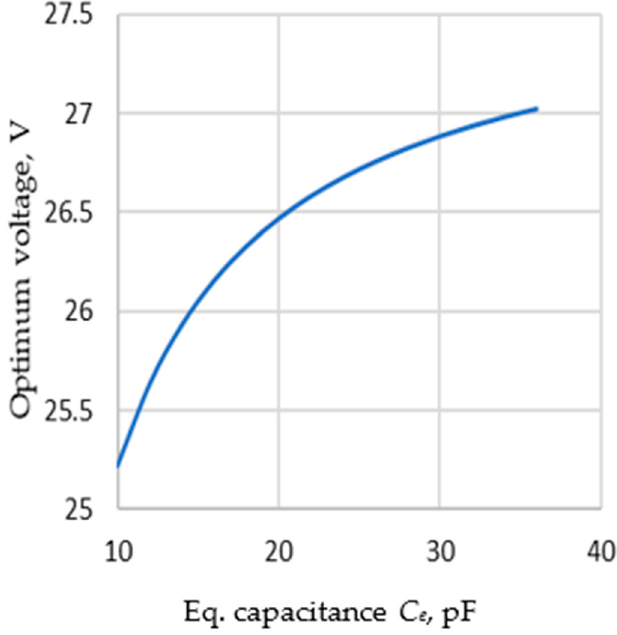
Figure 6. Variation of Optimum voltage for the variation of equivalent capacitance C e in pF ( I r = 10 nA).